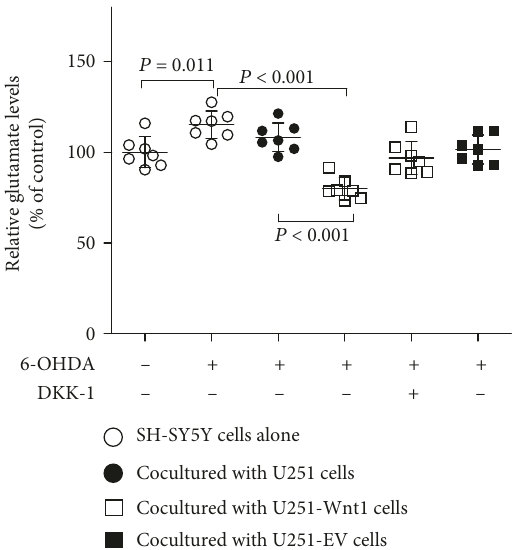
Figure 6: Wnt1 overexpression decreased the glutamate level in culture medium. SH-SY5Y cells were indirectly cocultured with U251 cells, U251-Wnt1 cells, or U251-EV cells and then treated with or without 50 μ M 6-OHDA or 100ng/ml DKK-1 for 24 h, and the glutamate levels in culture media were detected by ELISA. The data are expressed as percentages relative to the control group. All of the data are presented as the mean ± SD from 7 independent experiments. Di ff erences among groups were examined by using ANOVA followed by Tukey-Kramer tests for post hoc multiple comparisons. F value = 15.87, df = 5 , betweengroups = 36 , and df = 41 df withingroups total